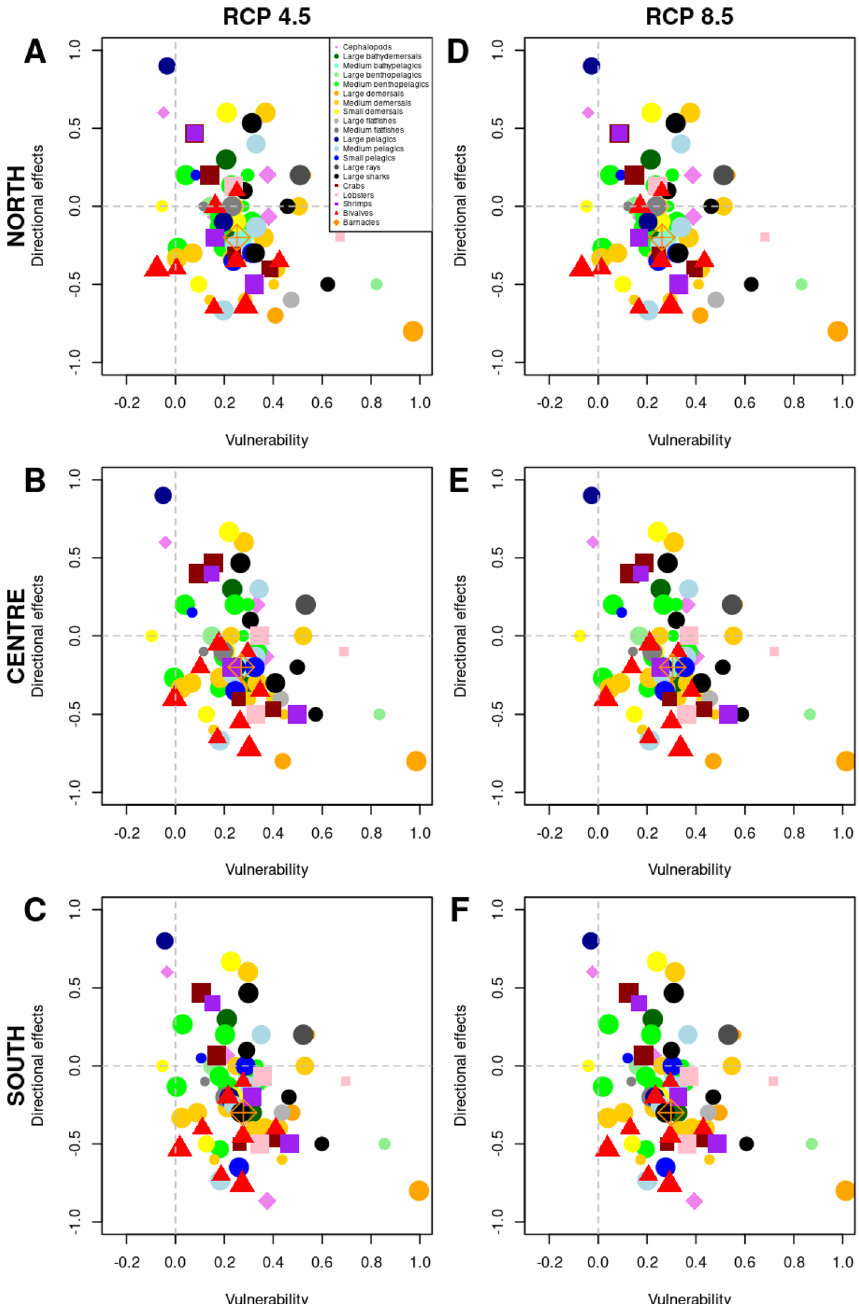
Figure 3. Relationship between overall vulnerability and directional effects for the species under study, considering the three regions of Portugal (North, Centre, and South) and the two scenarios of climate change (RCP 4.5 and RCP 8.5). The size of the points represents the confidence of the vulnerability assessment according to the bootstrap analysis carried